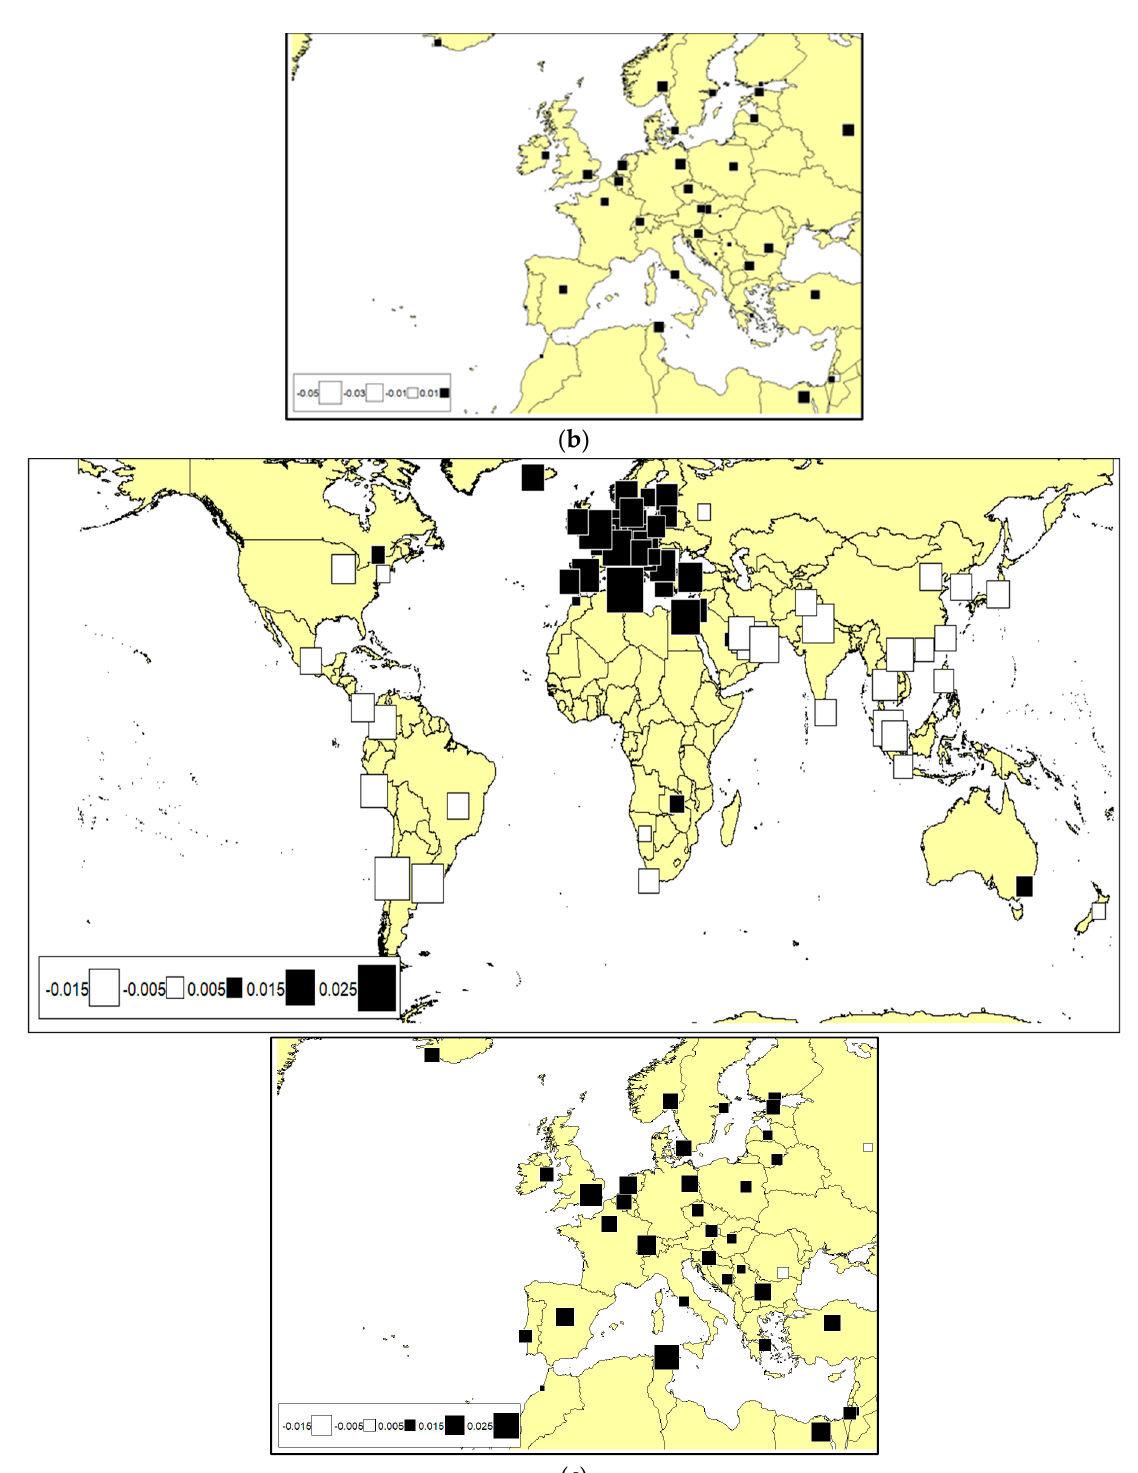
Figure A5. Map of projected first positive PC scores from FASPCA and Gabriel graph-based con- nection network; The smaller map below each bigger map is the zoom-in of Europe: ( a ) period 1; ( b ) period 2; ( c ) period 3.